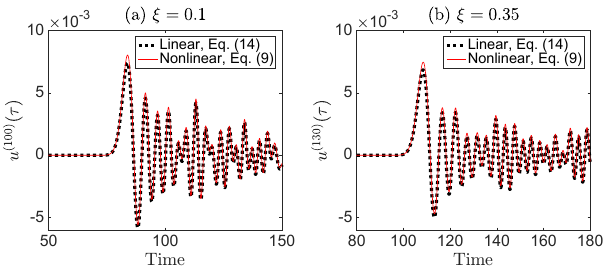
Figure 3. The displacement as a function of time is shown for the 100th particle in a chain of particles with disorder parameter ξ = 0 . 1 in (a) and the 130th particle in a chain of particles with disorder parameter ξ = 0 . 35 in (b) for impulse v o = 0 .